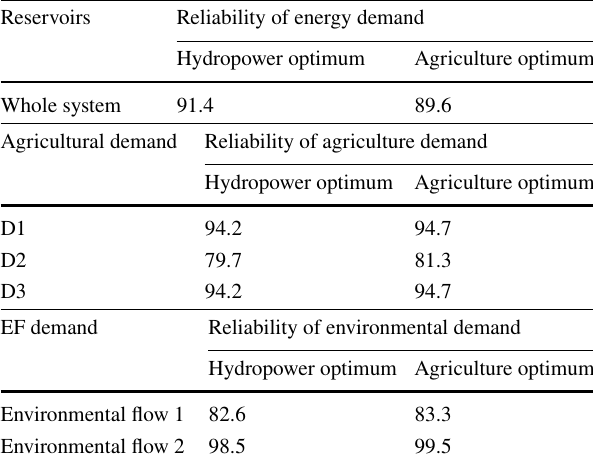
Table 3 Reliability of the system in two extreme points of scenario 2 Reservoirs Reliability of energy